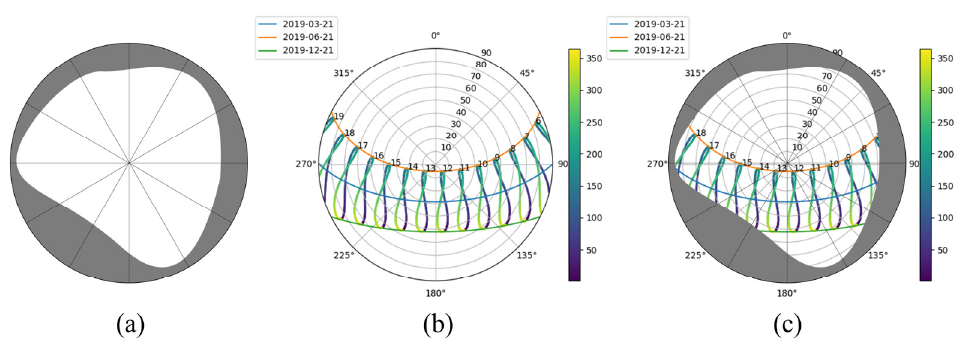
Figure 3. Basic principles for solar access analysis. ( a ) Viewshed, ( b ) solar path, and ( c ) overlay of viewshed with solar path.